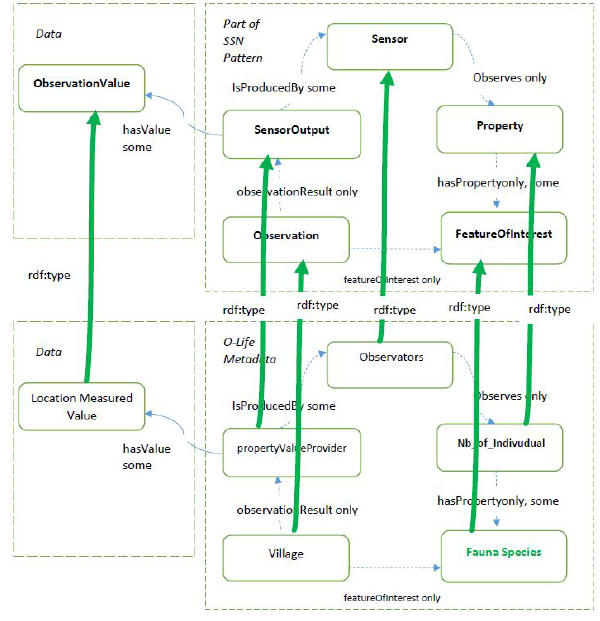
Figure 10. Running example: SSN mapping on the species.